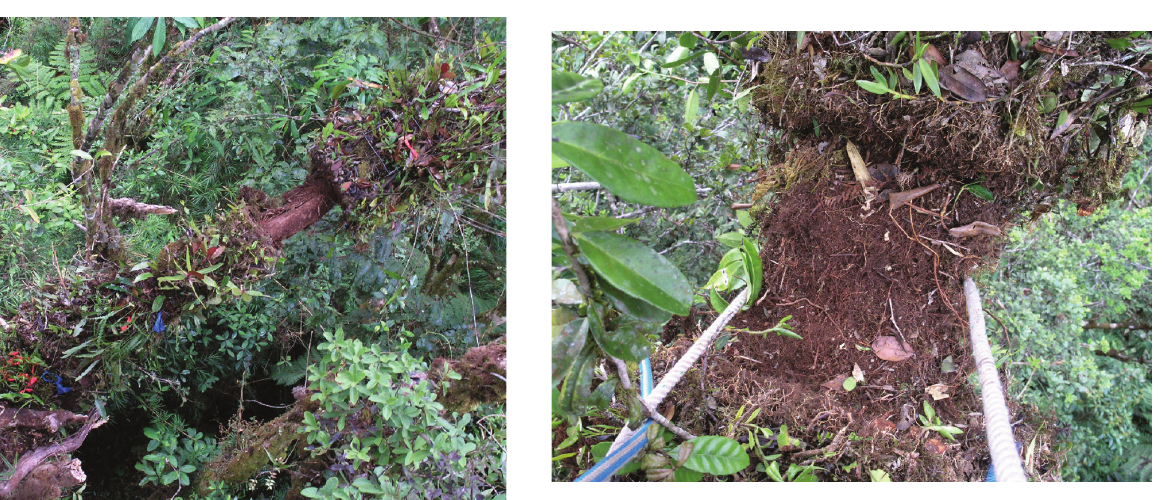
Figure S2. Mat removed. A transplanted mat was removed from this branch at 1650 m.